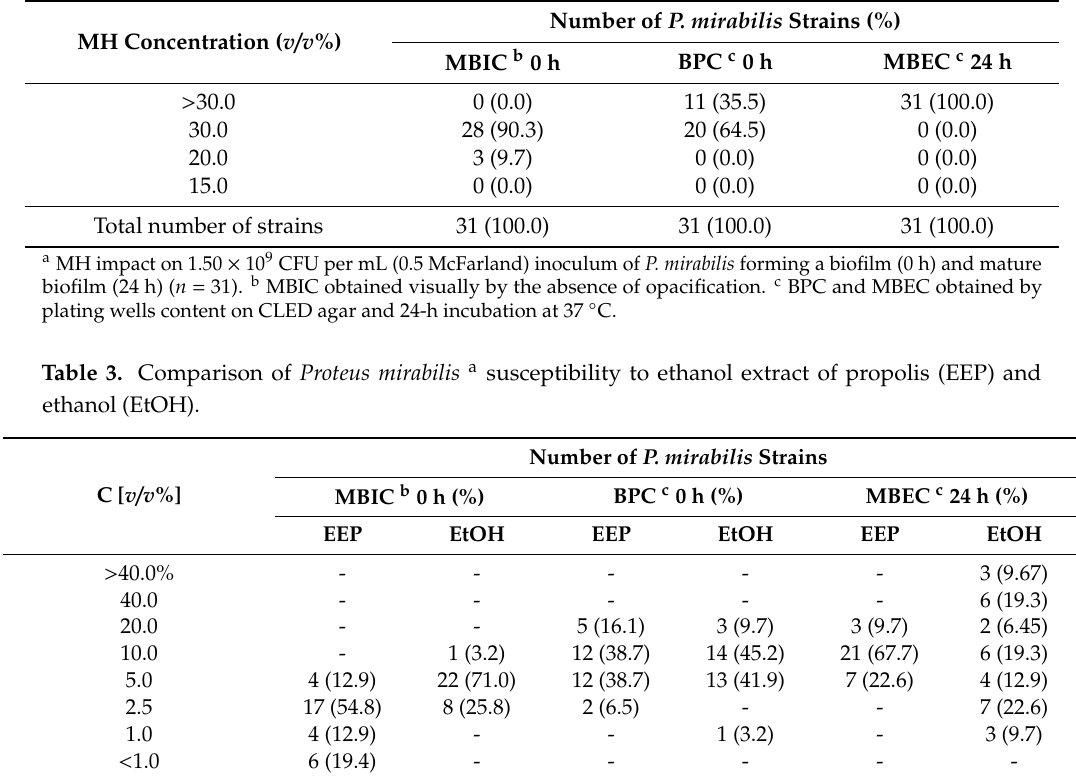
Total number of strains 31